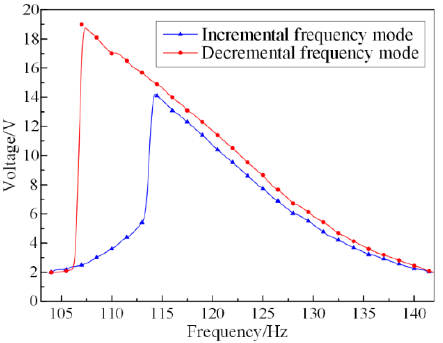
Figure 4. Dependency of the voltage on different frequency mode of the SPEH.